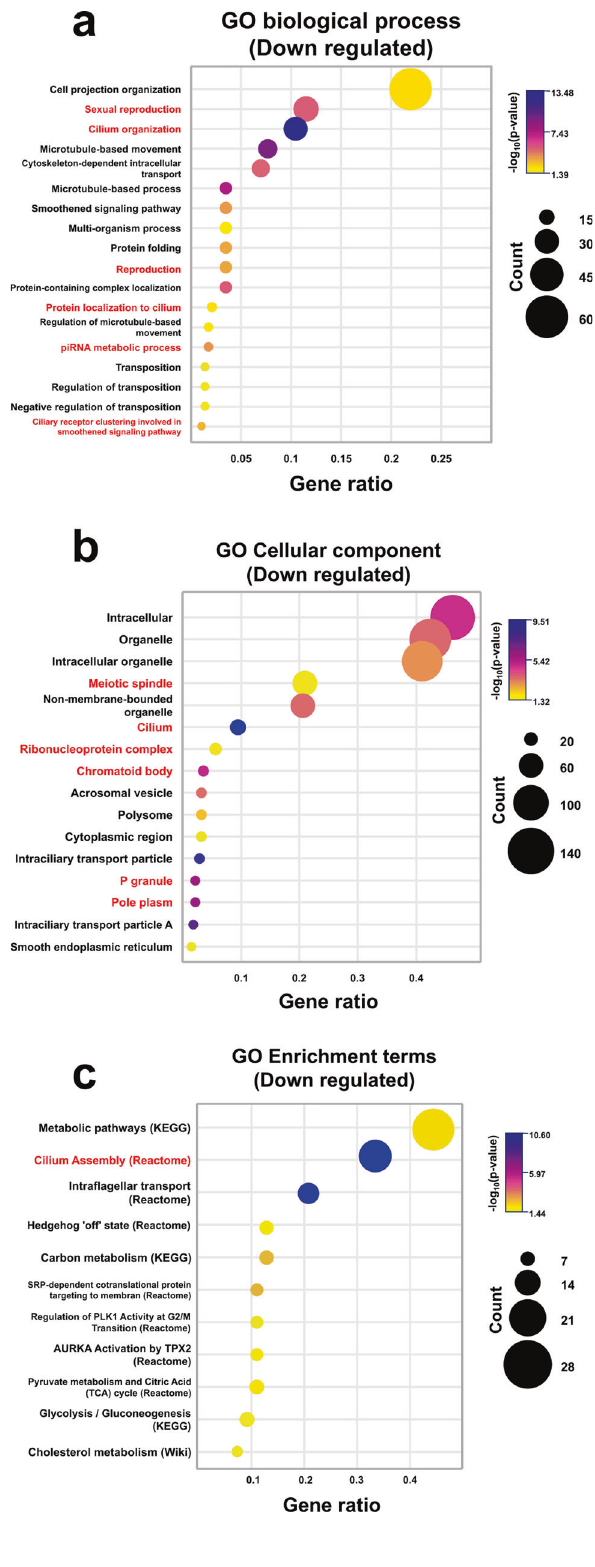
Among the proteins that interact with these proteins, the expression levels of Hspa2 and Eif4g3 proteins were signi fi cantly reduced in the infertile group because of Ubb- knockout as compared to that in WT mice [29, 30].